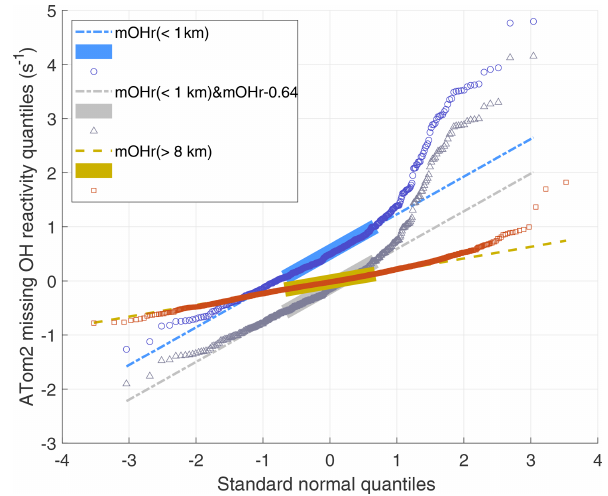
Figure 6. ATom2 quantile–quantile plot for 1min missing OH reac- tivity values above 8km (red squares) and below 1km (blue circles) versus a normal distribution with a mean of 0 and a standard de- viation of 1. The Q–Q plot for data taken below 1km but with the median value shifted by 0.64s − 1 (gray triangles) shows the effect of an incorrect absolute missing OH reactivity median. The values lie along the dashed lines if the missing OH reactivity values are normally distributed. This Q–Q plot is for ATom2; the Q–Q plots for ATom1 and ATom3 show less dramatic but similar behavior to that of